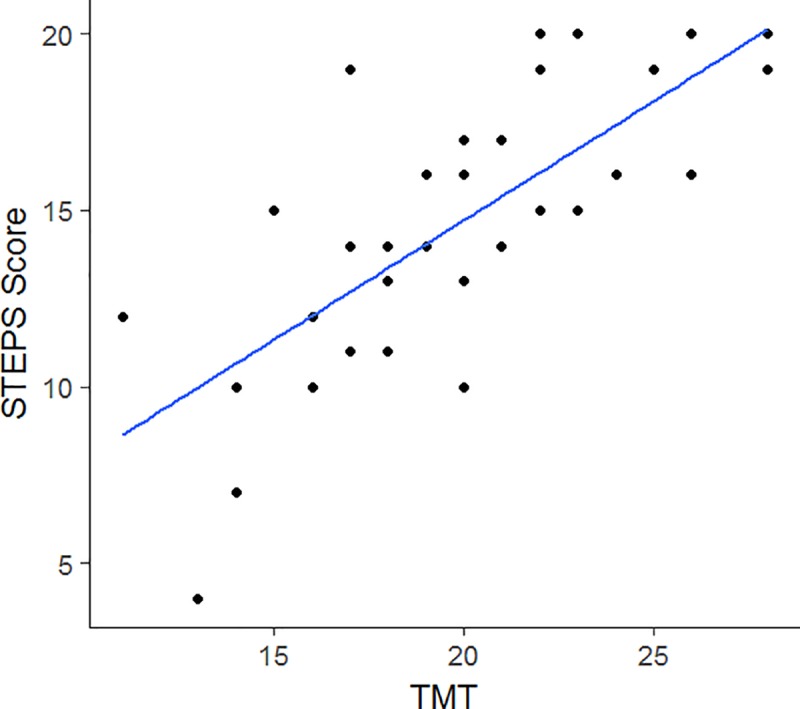
Univariable regression of Tinetti Mobility Test (TMT) versus STEPS scores.Higher scores on the TMT correlate with better gait and balance on flat terrain.